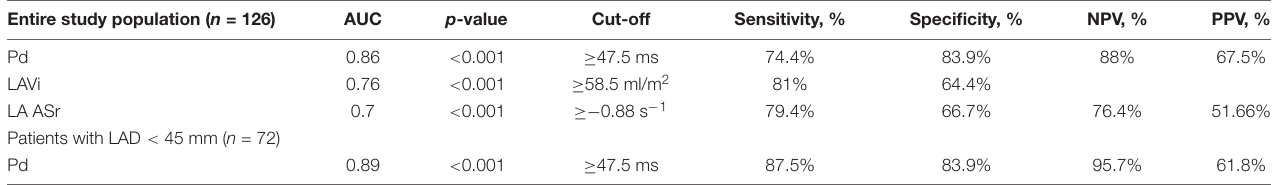
TABLE 3 | Electrocardiographic and echocardiographic predictors of new-onset AF with the prespecified cut-off values in the whole HCM group and in HCM patients with LAD < 45